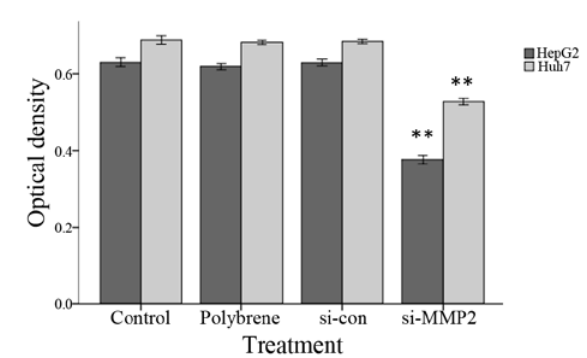
Figure 2: Effects of MMP2 knockdown on cell proliferation of HepG2 (at 48 h after transduction) and Huh7 cells (at 72 h after transduc- tion) using MTT assays. ** P<0.01 vs. the normal control group according to one-factor analysis of variance (ANOVA) followed by a post hoc least significant difference (LSD)